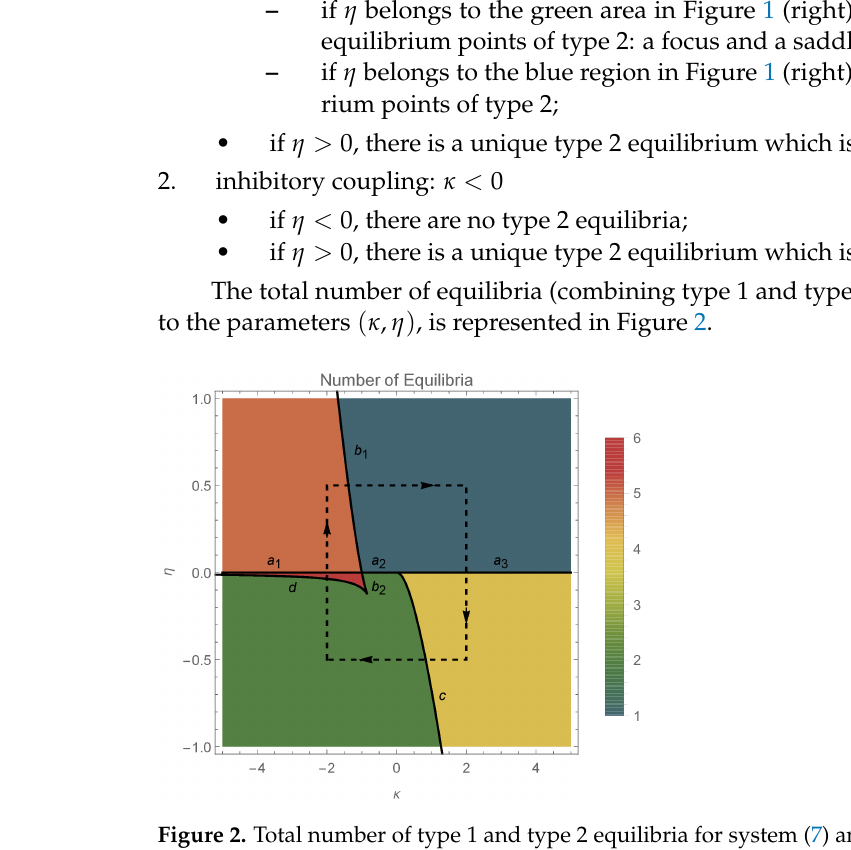
Figure 2. Total number of type 1 and type 2 equilibria for system (7) and